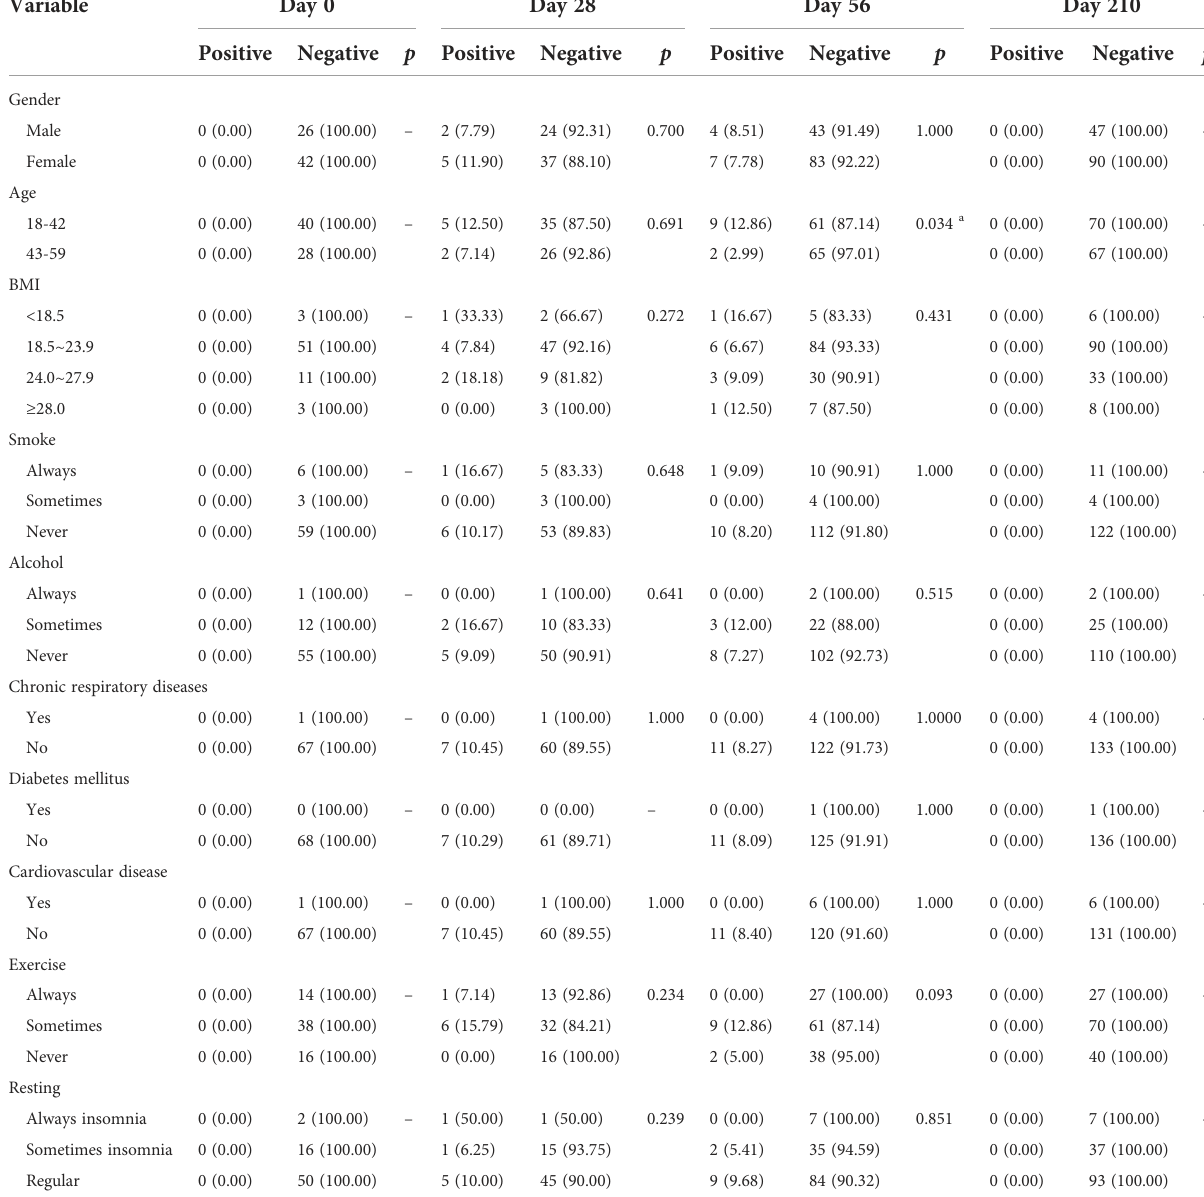
TABLE 5 Associations between participants ’ characteristics and antibodies to IgM.